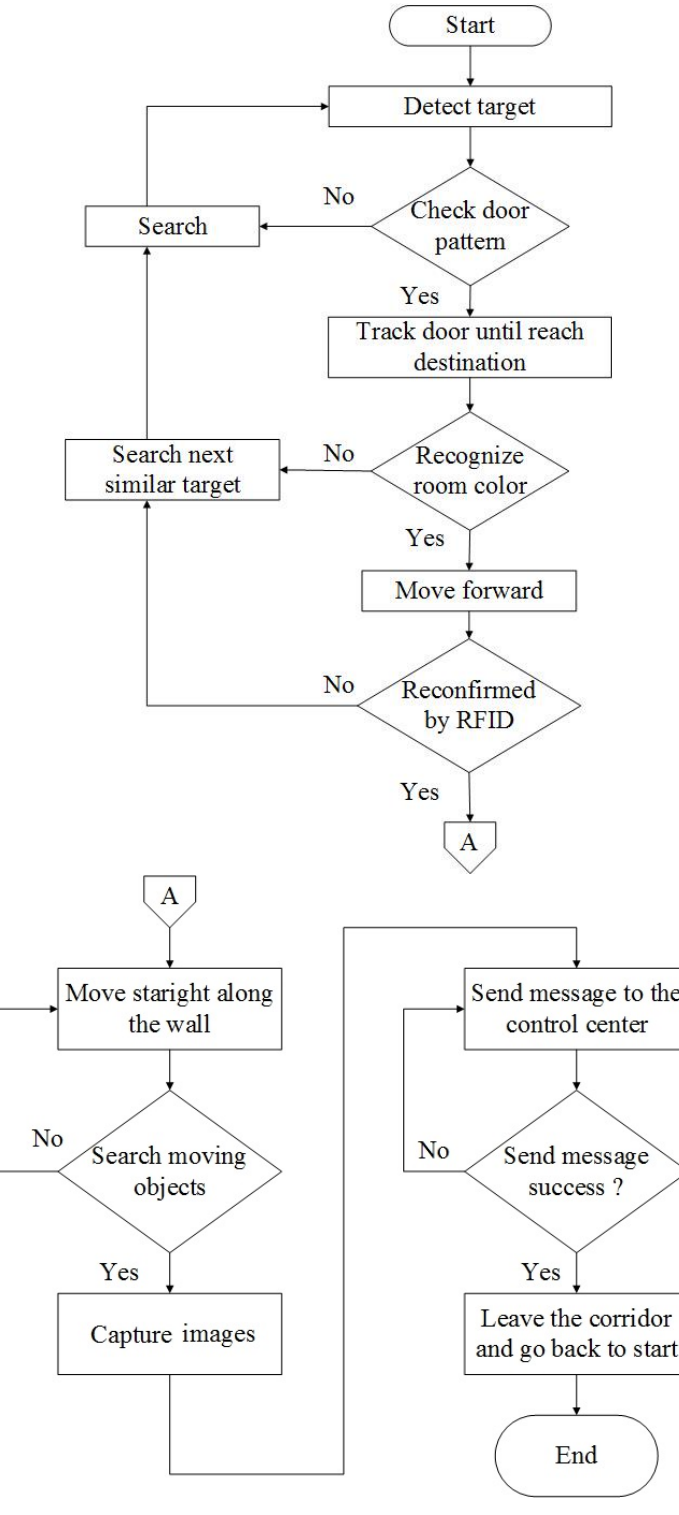
Figure 15. Flowchart of control sequence.